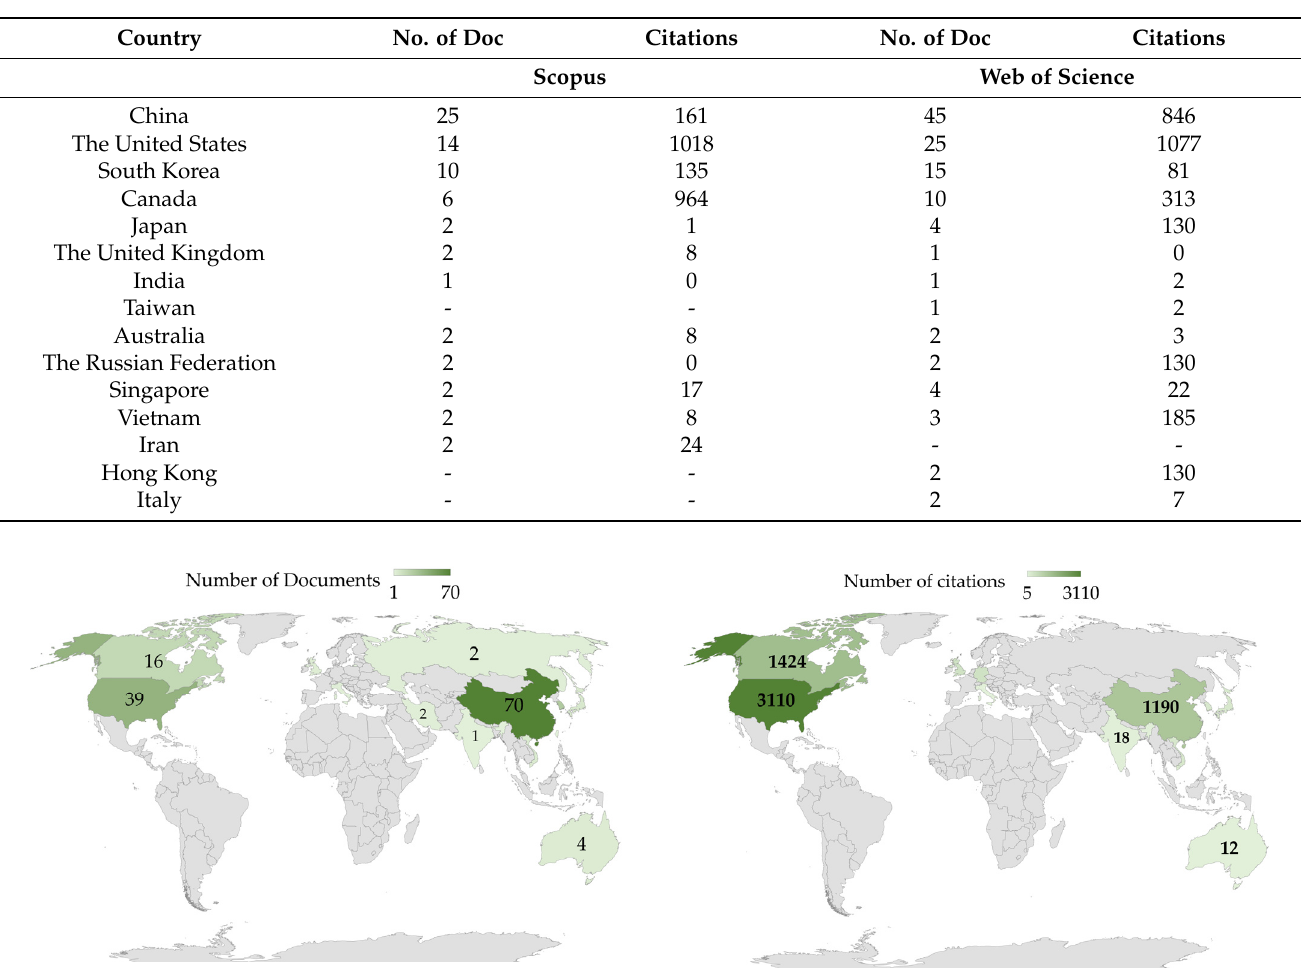
Table 9. Number of documents and citations of the top countries contributing to the research theme.